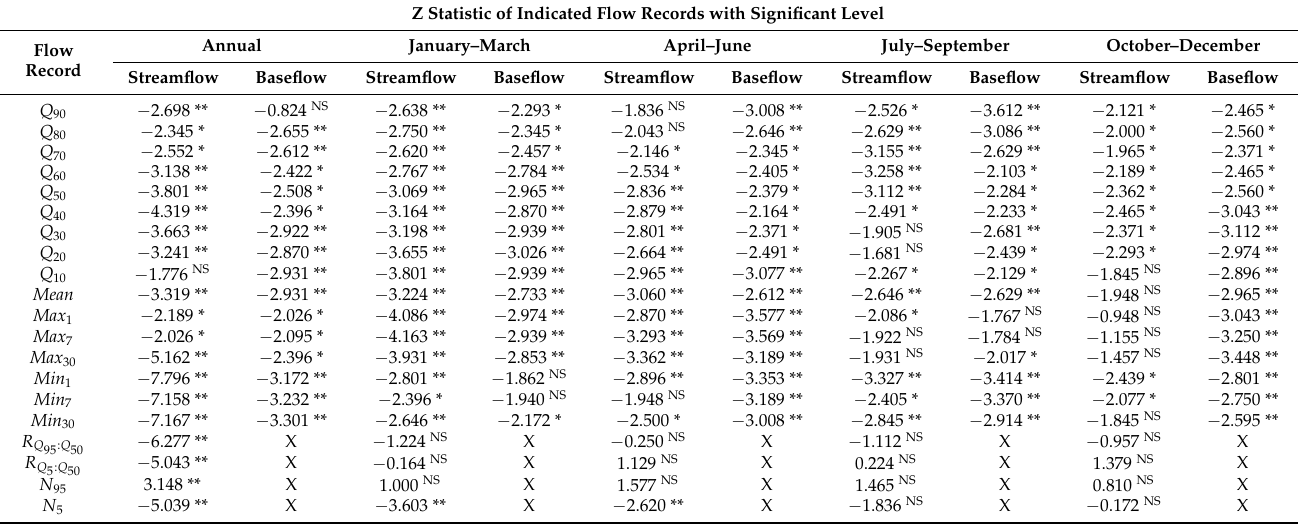
Table 1. Results of trend analysis for flow record in the Beiluo River Basin during. Z Statistic of Indicated Flow Records with Significant